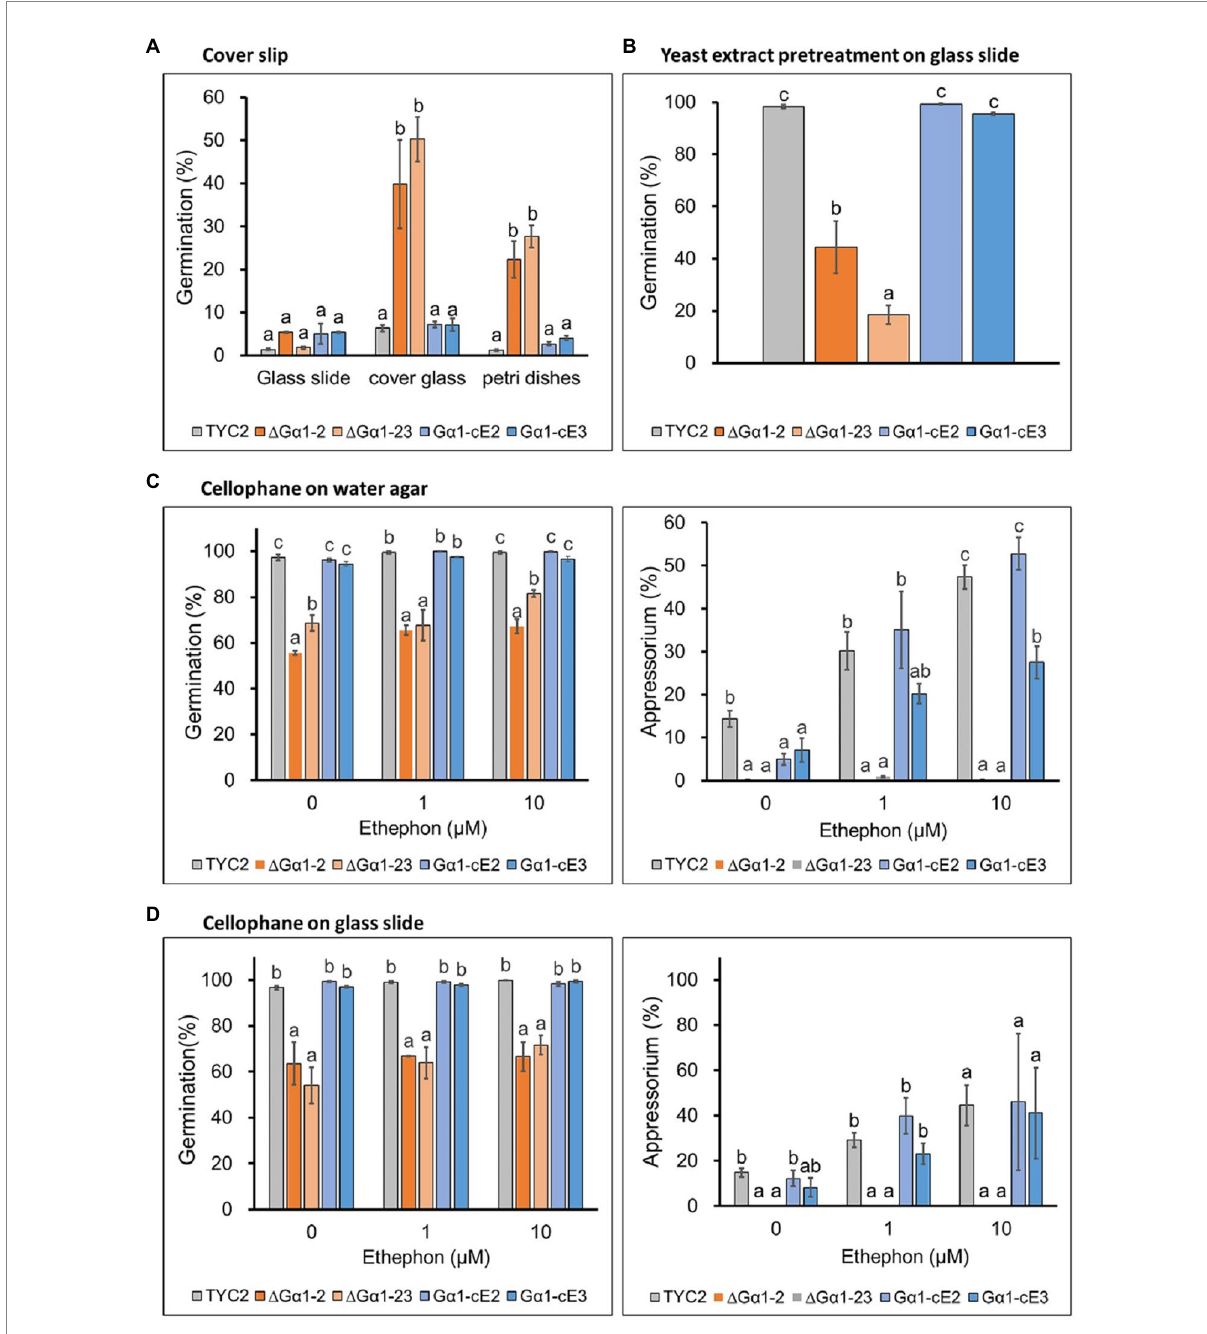
FIGURE 6 Spore germination and appressorium formation of Colletotrichum asianum wild-type strain (TYC-2), G 𝛼 1 mutants ( ∆ G 𝛼 1–2, ∆ G 𝛼 1–23) and gene complementation strains (G 𝛼 1-cE2, G 𝛼 1-cE3) on different surfaces at 3 h under 0–10 μ M ethephon. (A) Spore germination on cover slip. (B) Spore germination on glass slide after yeast extract pretretment. (C) Spore germination and appressorium formation on cellophane topping on 1.5% water agar. (D) Spore germination and appressorium formation on cellophane topping on glass slide. The data within same treatment were analyzed by one-way ANOVA, different letters indicate significant differences between treatments ( p value